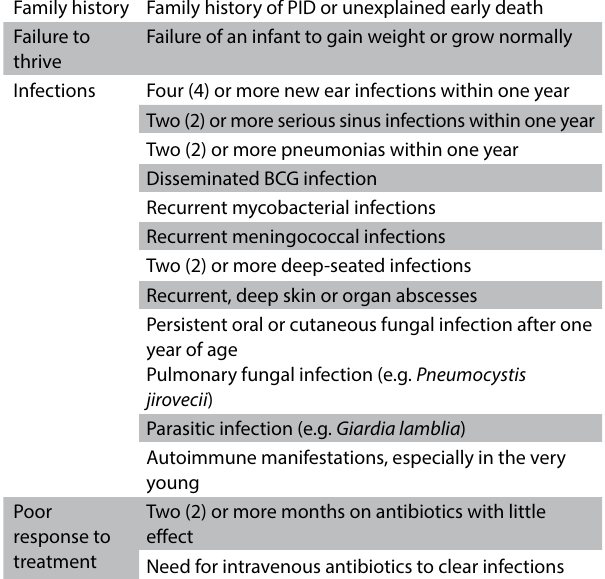
Table I. Warning signs of